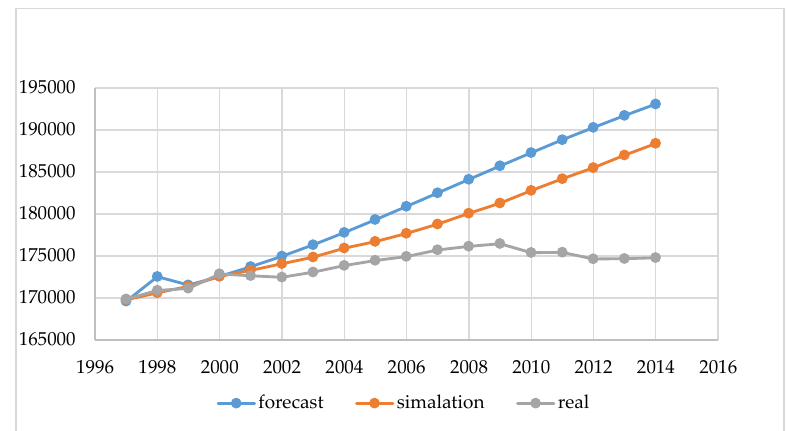
Figure 7. The Demographic Forecast of Olsztyn (Years 1997 – 2014). Source: own study based on CSO [24].